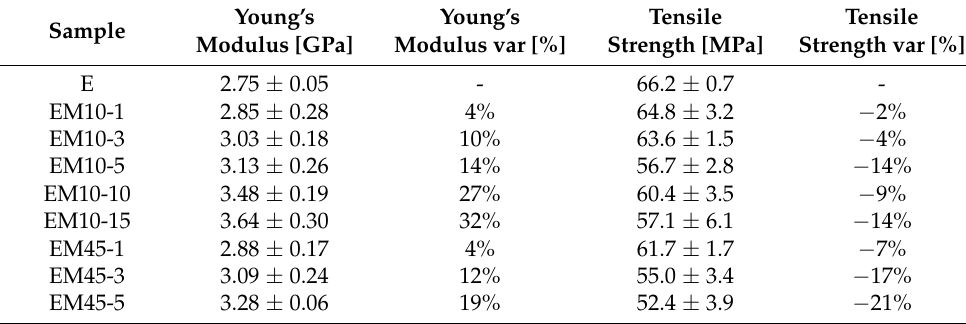
Figure 9. Selected specimens for fracture tests (CT) and tensile tests (DB) of neat epoxy resin (E), nanocomposite with 5% wt of Mica 10 (EM10-5), and nanocomposite with 5% wt of Mica 45 (EM45-5). Table 4. Results from tensile tests. Values are reported in terms of mean value and standard deviation. Variation column reports the variation of the mean value with respect to neat